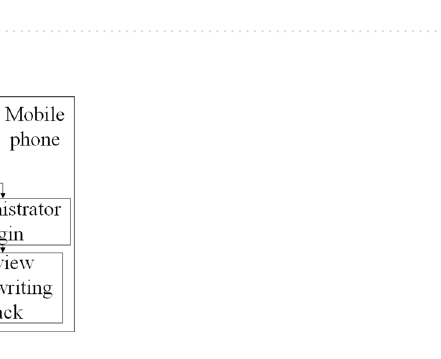
Figure 3. Architecture diagram of the handwriting trajectory acquisition